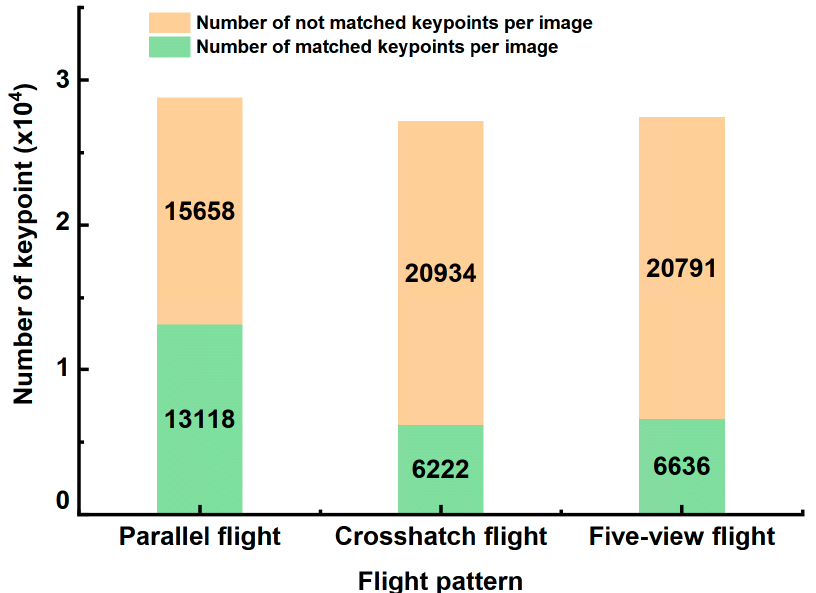
Figure 10. The average number of detected key points and matched points per image acquired under different flight patterns.